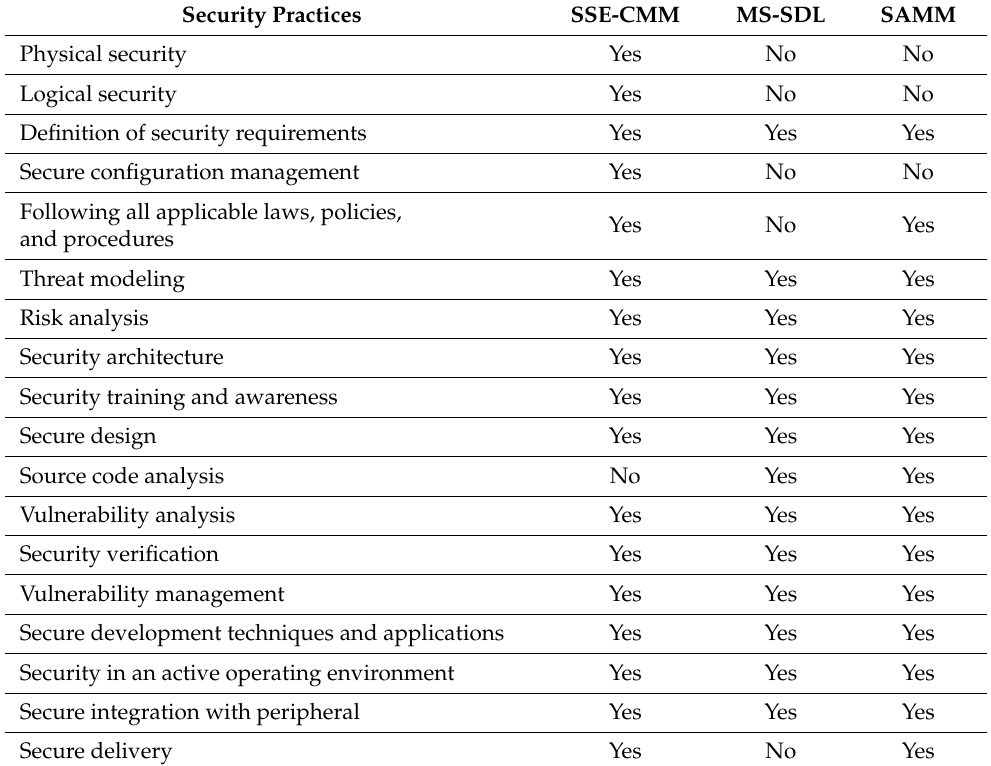
Table 2. Comparison of existing